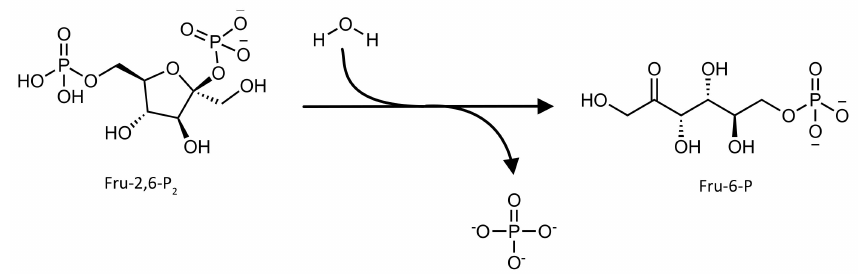
Figure 2. Schematic representation of the reaction catalyzed by the FBPase-2 domain of the PFK- 2/FBPase-2